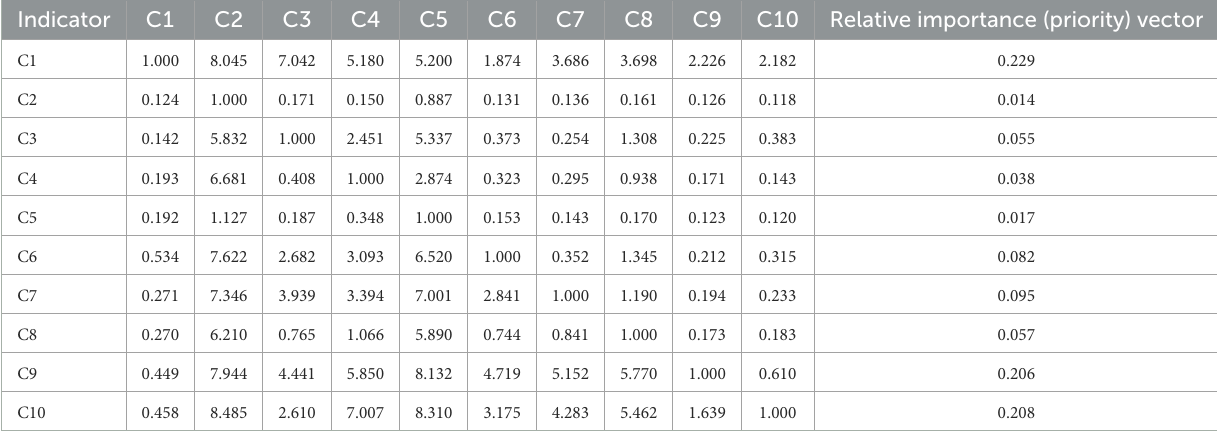
TABLE 3 Group decision matrix and relative importance (priority)